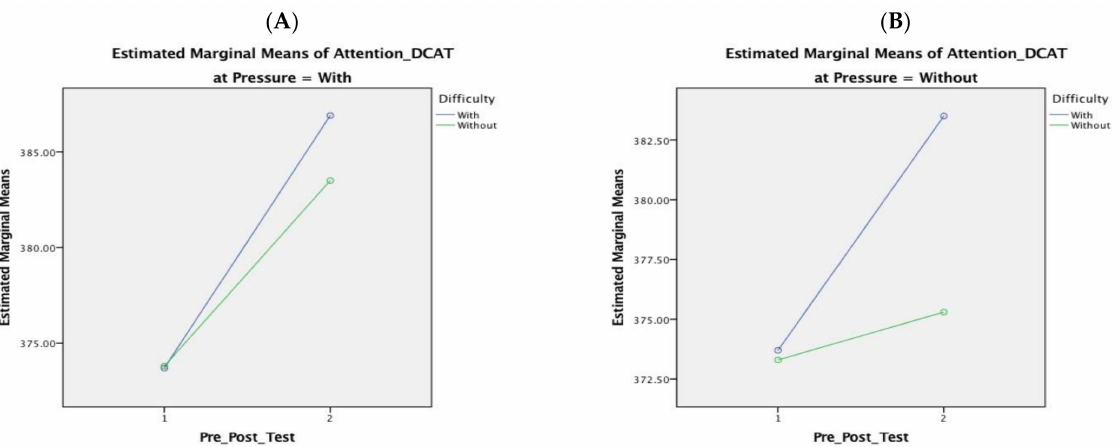
Figure 7. The graph of three-factor interaction in D-CAT. Figure ( A ) shows the interaction of pre/post- test * difficulty with pressure condition; Figure ( B ) shows the interaction of pre/post-test * difficulty without pressure condition. Note: pre/post-test (the horizontal axis), pre-test = 1, and post-test =